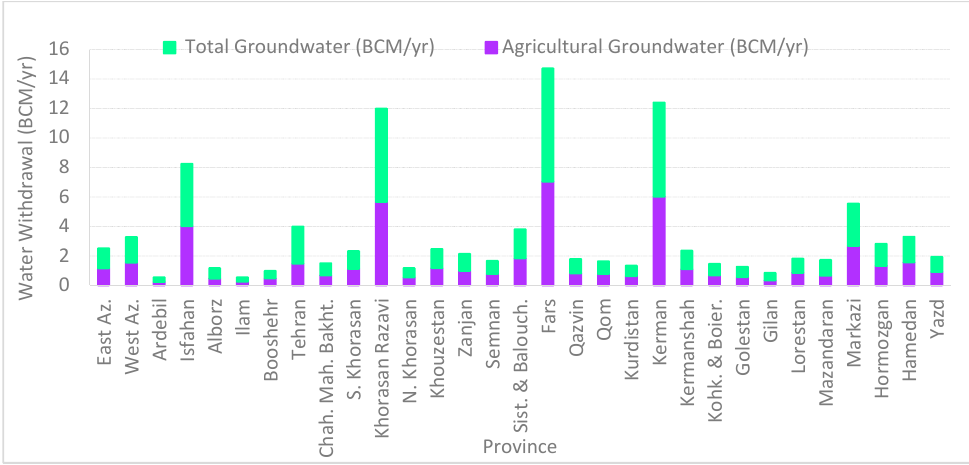
Figure 6. Total and agricultural groundwater withdrawal in different Iranian provinces in 2011.